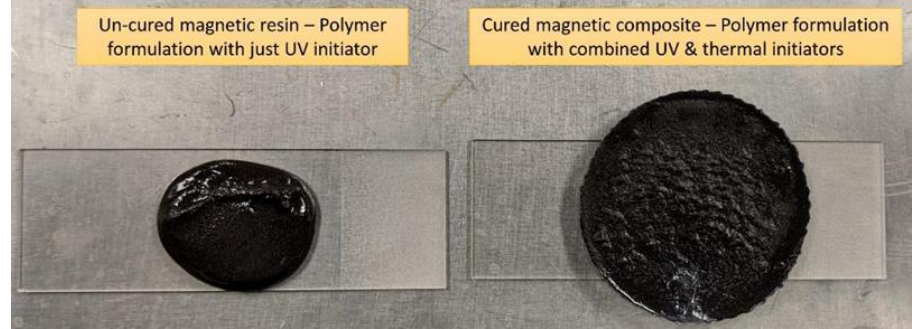
Figure 1. Thermal cure evaluation of dual-cure prepolymer reinforced with magnetic fillers.